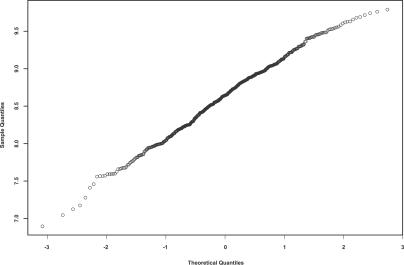
QQplot of Viral Loads, Generated from Variable Activation Parameter (α) against a Normal Law